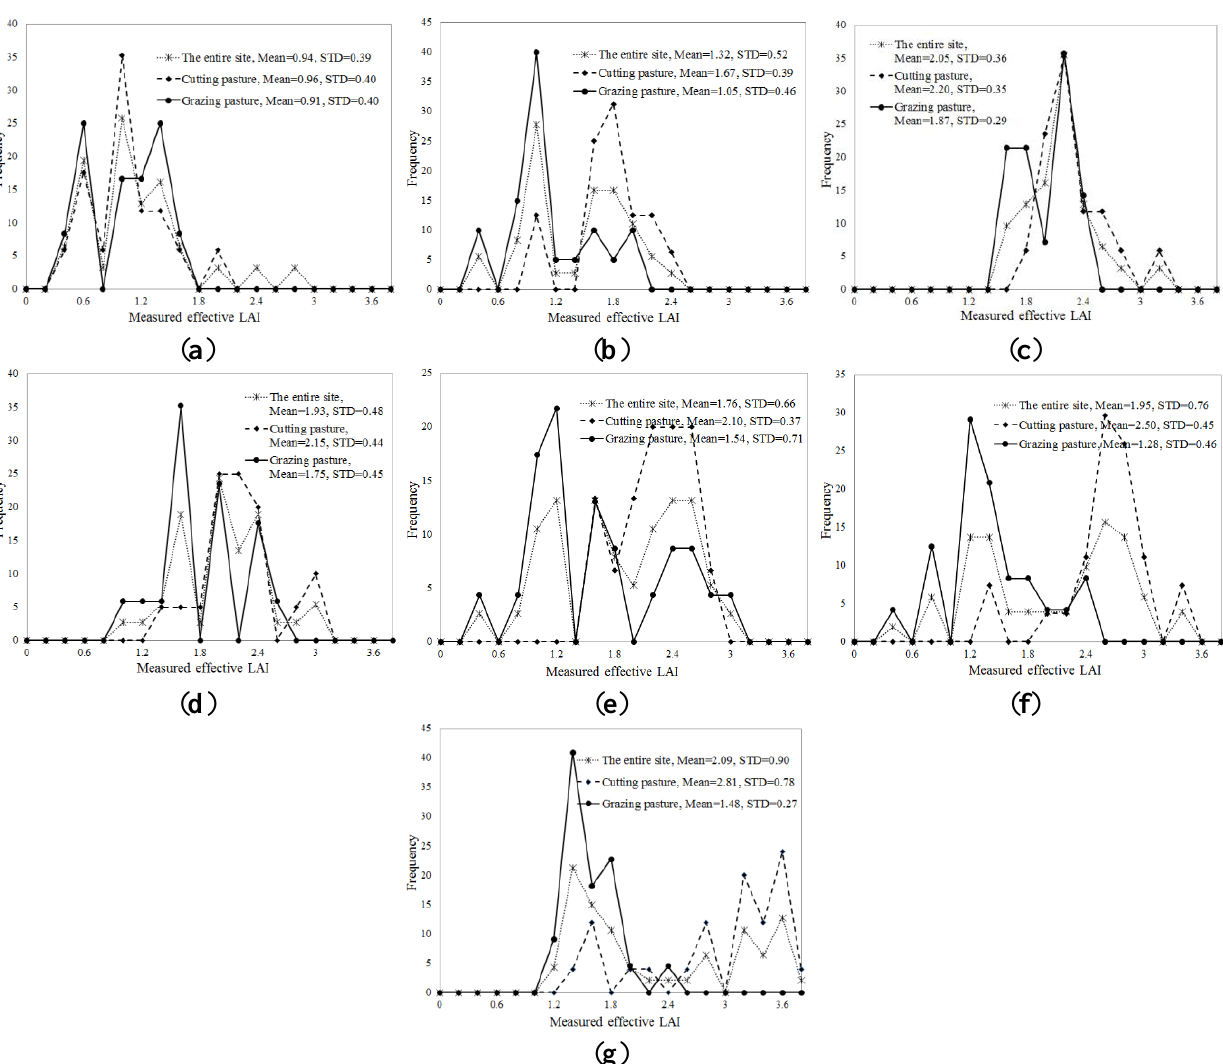
Figure 3. Distribution of the measured effective LAI values collected in different stage of the growing season. ( a ) 4 June; ( b ) 23 June; ( c ) 6 July; ( d ) 13 July; ( e ) 25 July; ( f ) 11 August; ( g ) 19